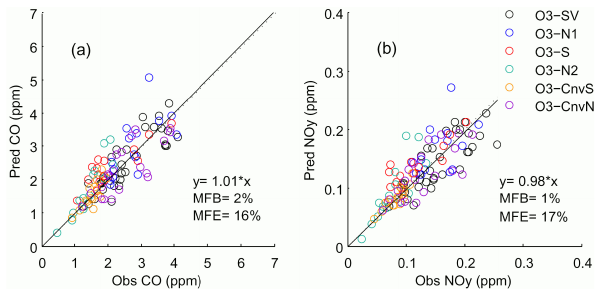
Fig. 2. Scatter plot of simulated and observed concentrations of (a) CO and (b) NO y averaged over 15 RAMA monitoring sites during all episodes. Scatter plots only show datasets during 7:00-11:00 LT for CO and NO y . Performance statistics are also shown. The dashed lines indicate a perfect positive correlation, and each color indicates a different meteorological episode.